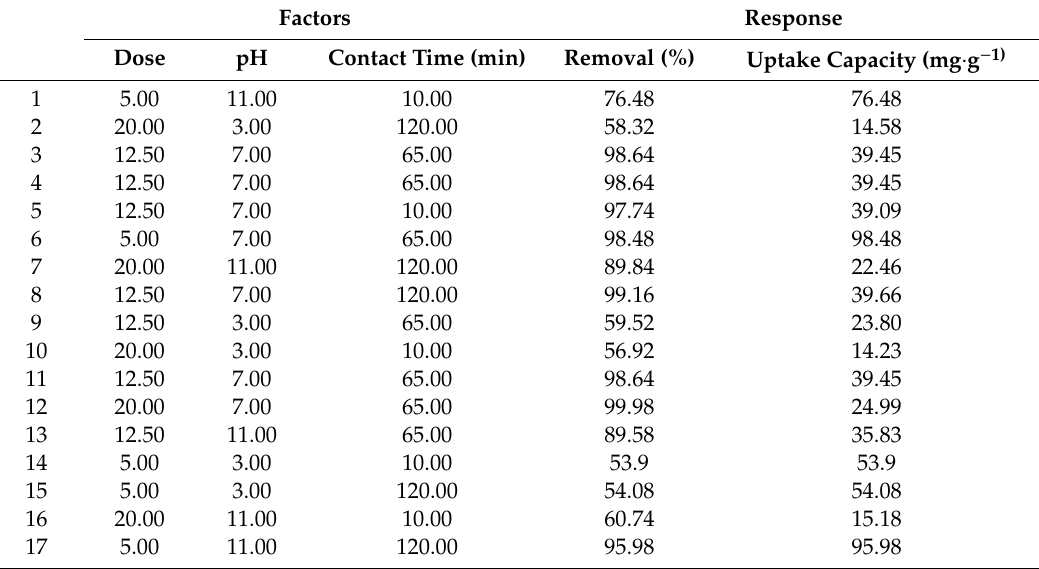
Table 3. List of Design of Expert (DoE) runs and actual